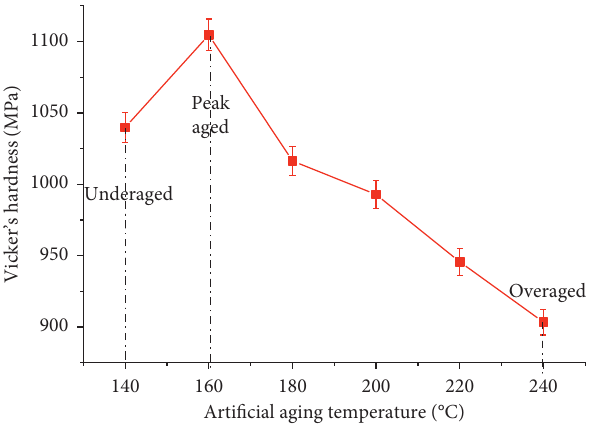
Figure 2: The hardness variations with artificial aging temperature.